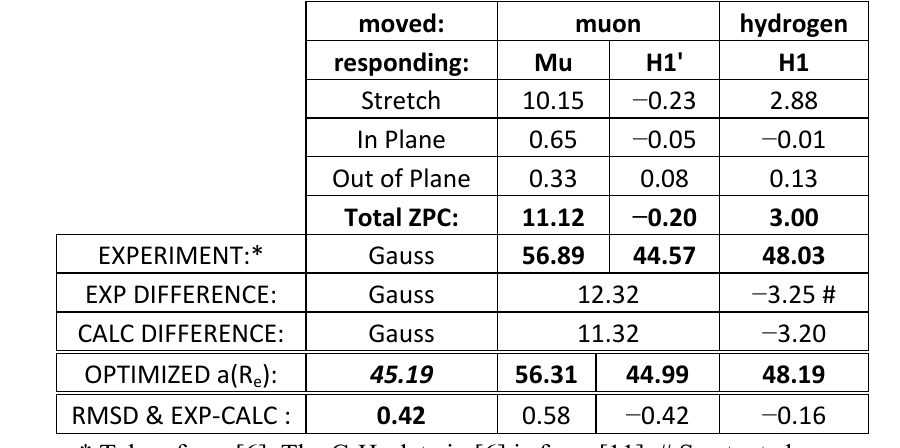
Table 1. Summary of calculations and comparison with experiment (all values in Gauss).